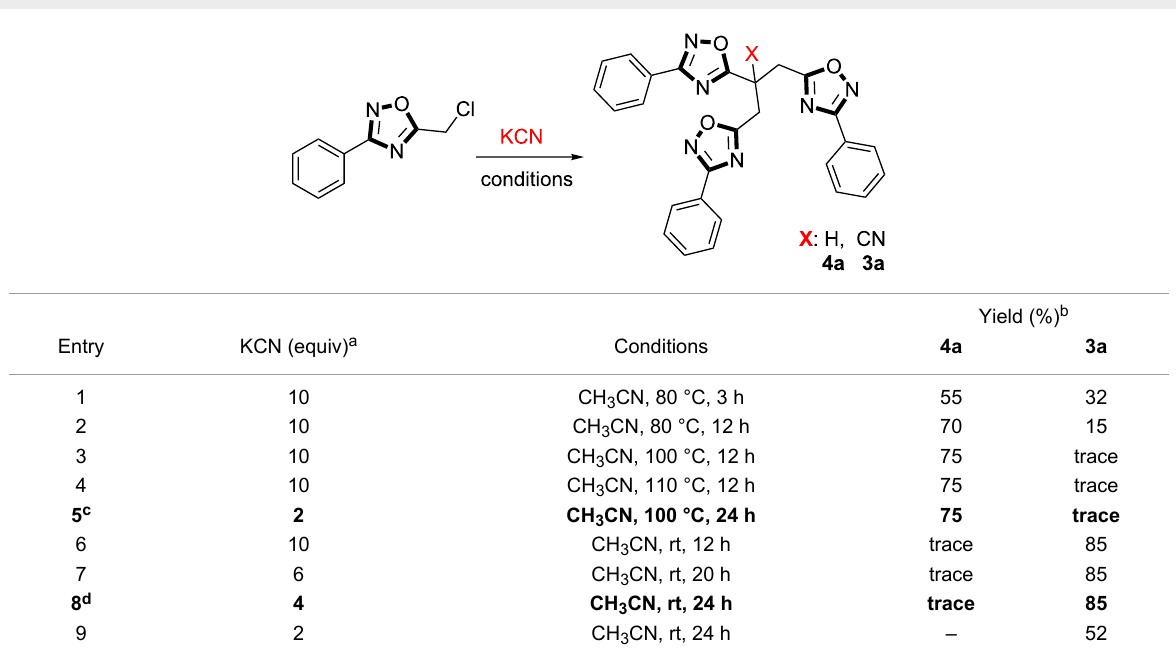
Table 1: Optimisation of reaction